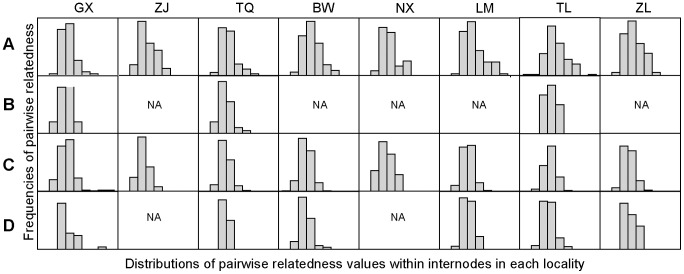
Distributions of pairwise relatedness values within internodes in each locality from microsatellite data.(A) females within internodes (locality numbers = 8), (B) males within internodes (locality numbers = 3), (C) females between internodes (locality numbers = 8), (D) males between internodes (locality numbers = 6). NA, missing plot because of less than five comparisons within localities. Values within each plot stand for mean±SD.